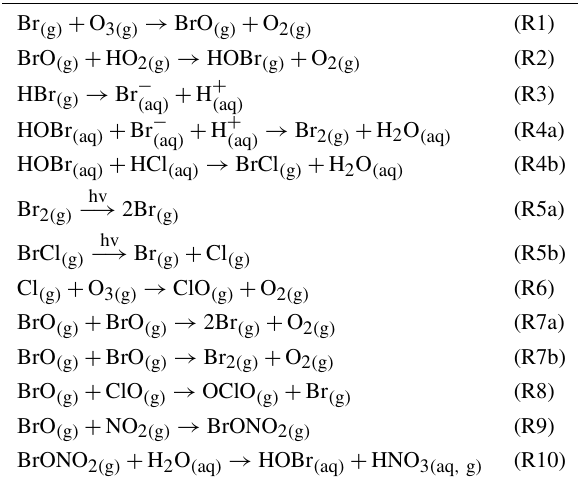
Table 1. Overview of halogen reactions in volcanic plumes ( X = Cl,